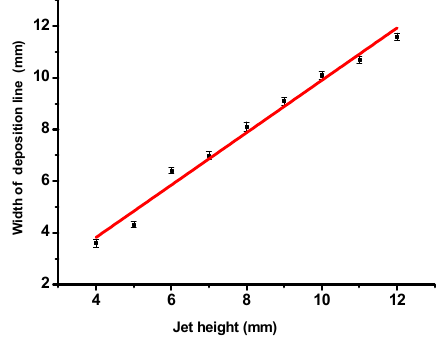
Figure 3. Relationship between jet height and width of a single deposition line.